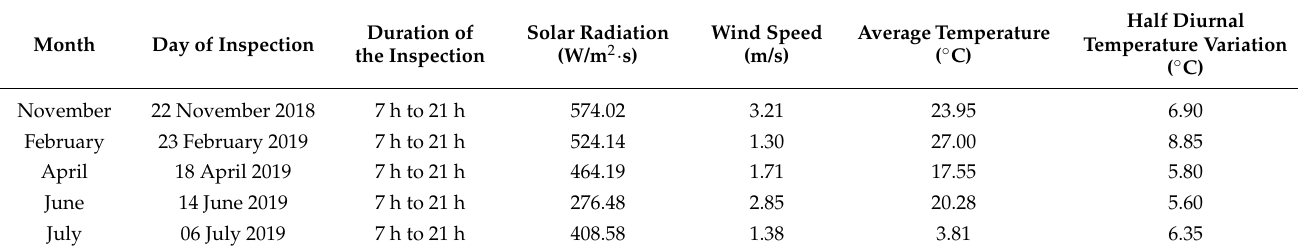
Table 1. Inspection and meteorological data used in the numerical simulation of the field tests.